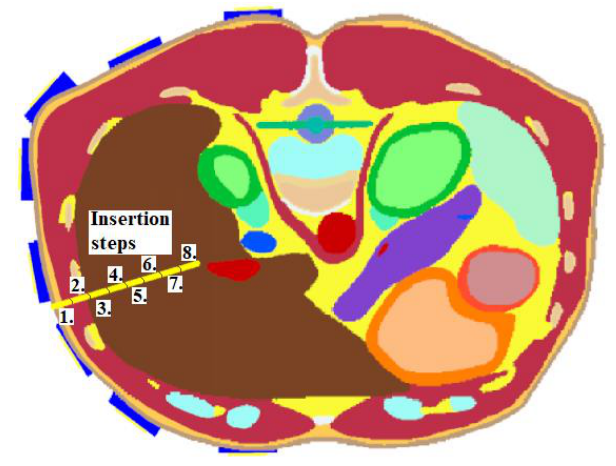
Figure 6. Insertion steps 1–8 of the ablation catheter.